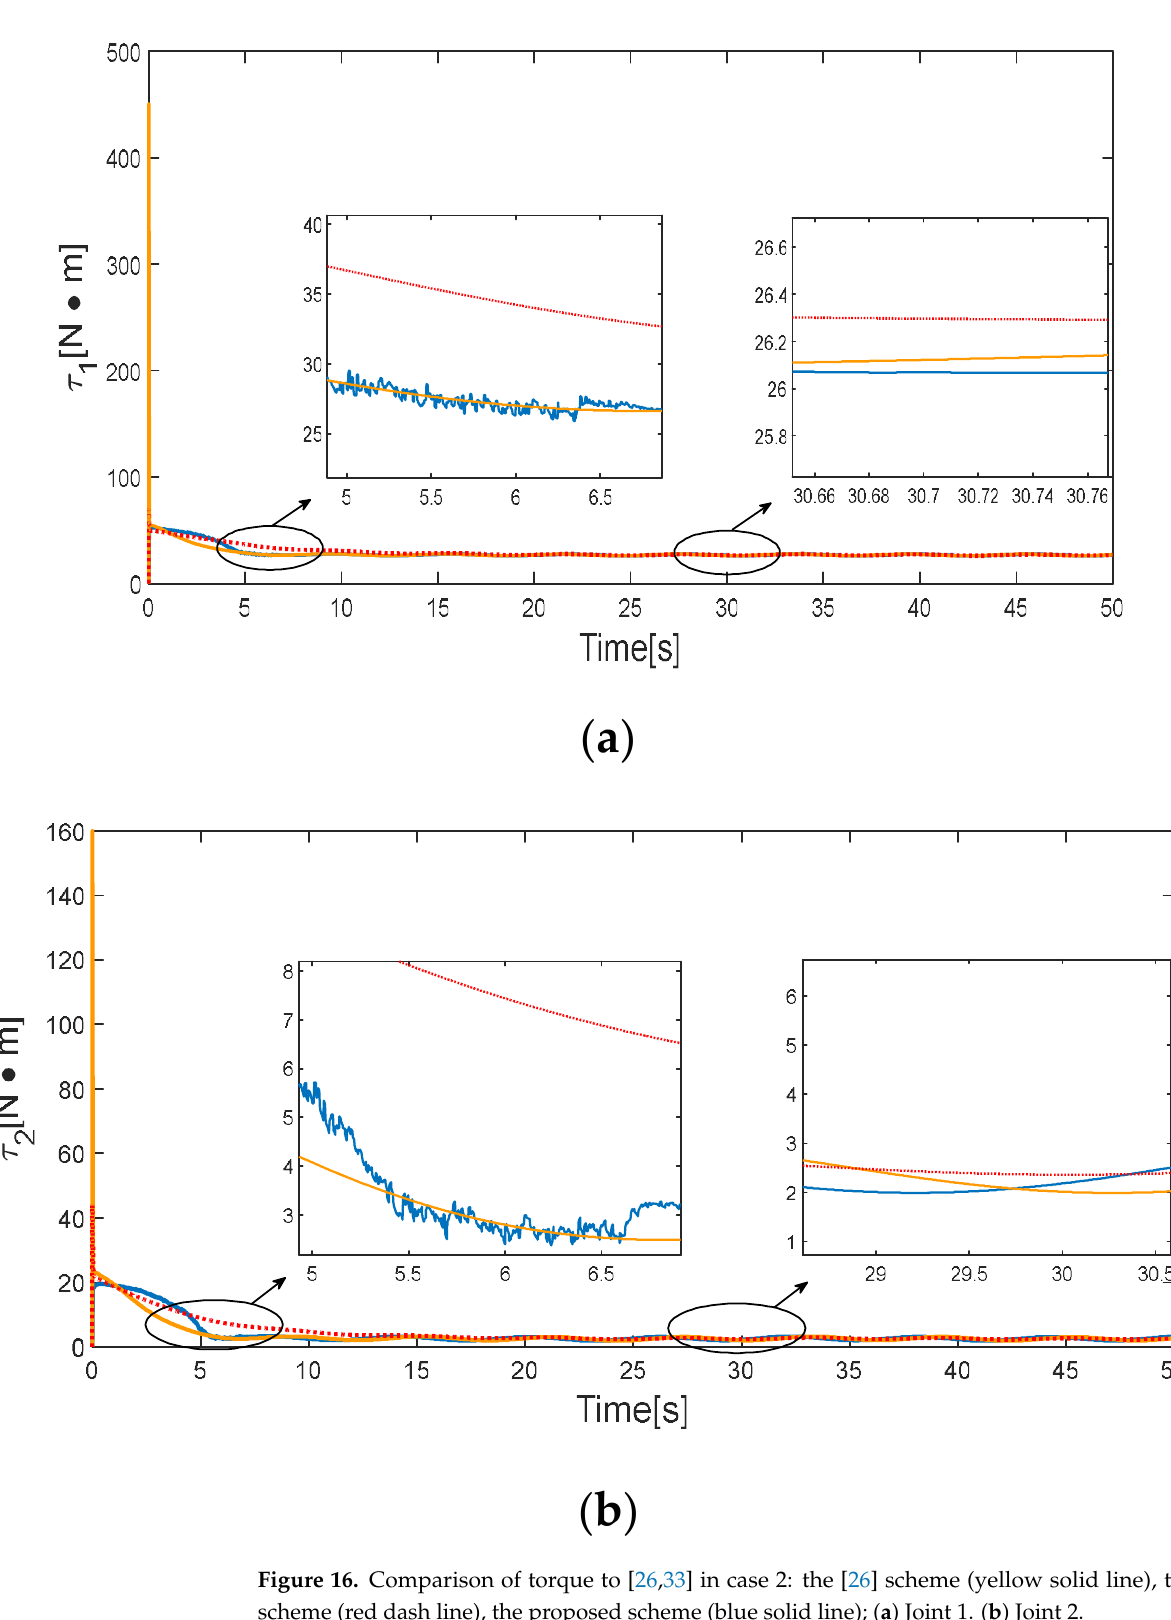
Figure 16. Comparison of torque to [26,33] in case 2: the [26] scheme (yellow solid line), the [33] scheme (red dash line), the proposed scheme (blue solid line); ( a ) Joint 1. ( b ) Joint 2.